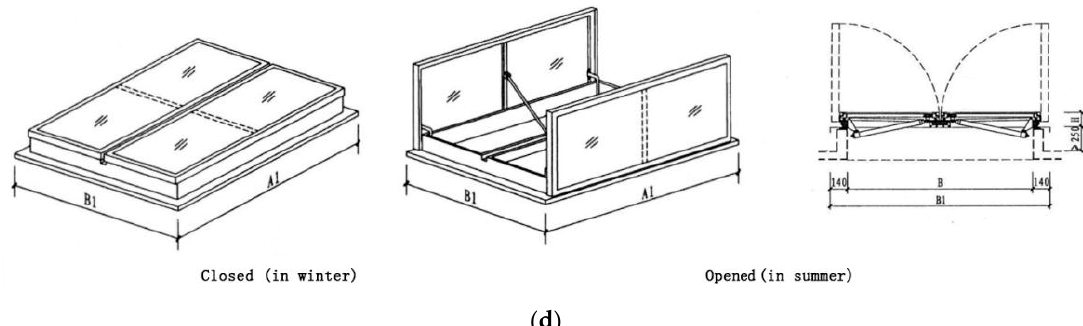
Figure 4. ( a ) The Image of CASE-A, ( b ) image of new tubular houses with different energy efficiency measures in Sketchup 2019, ( c ) image of new tubular houses with different energy efficiency measures in Cad2021, and ( d ) image of the sun- space windows.